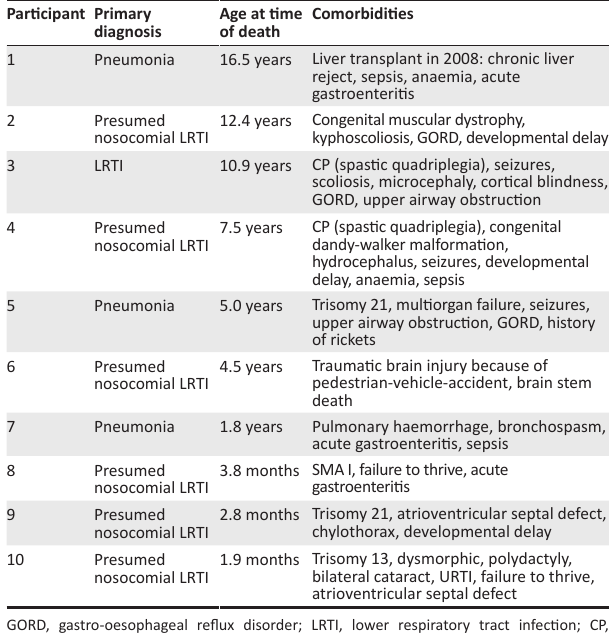
TABLE 6: Description of the deceased patients.